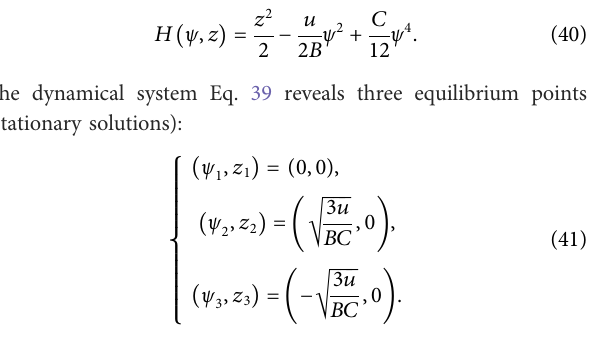
FIGURE 3 Periodic solution Cn for plasma parameters α =0.3, β =0.026, γ =0.7, δ =0.01, μ =0.1, ] =0.9, and m =0.8. Here, A > 0 and 2 m 2 − 1 > 0.